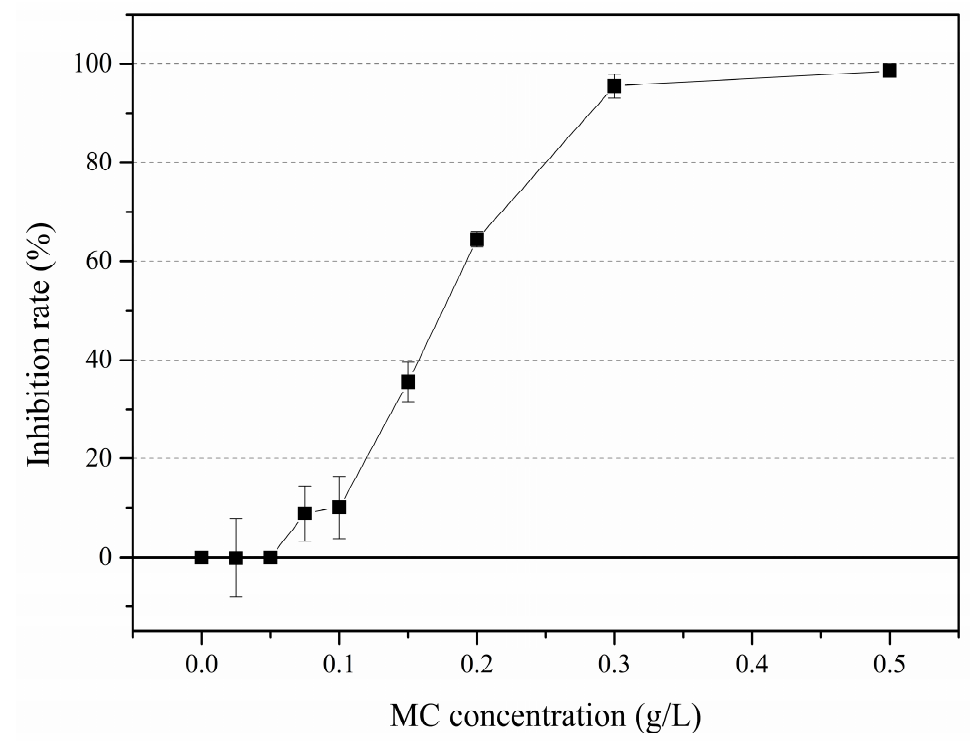
Figure 2. Inhibition rates of the growth of P. globosa solitary cells on the 10th day under different MC concentrations.